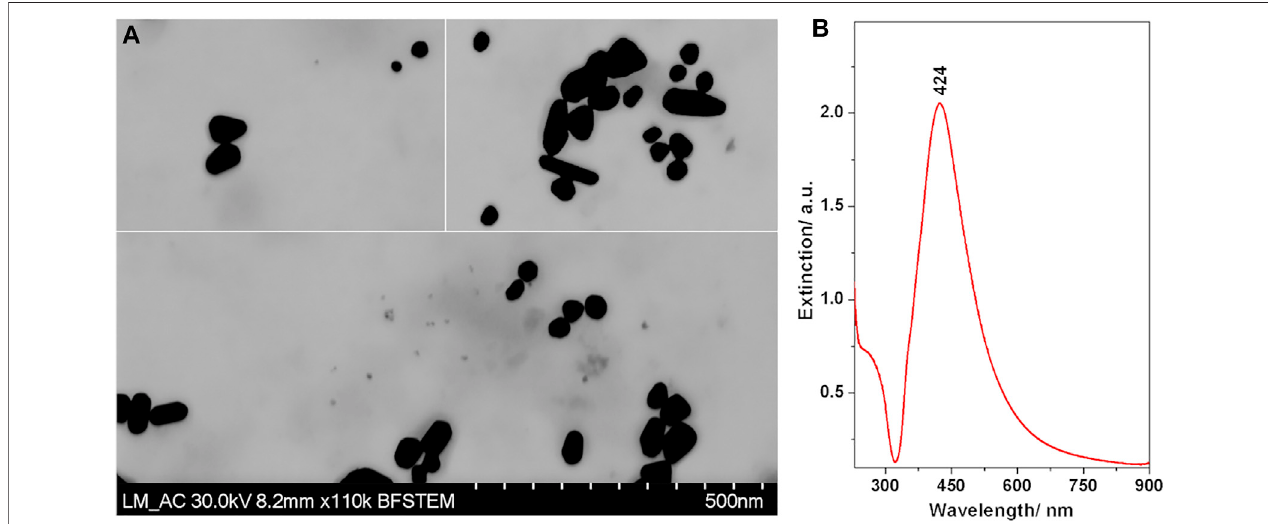
Figure 3A under different lighting and background conditions.